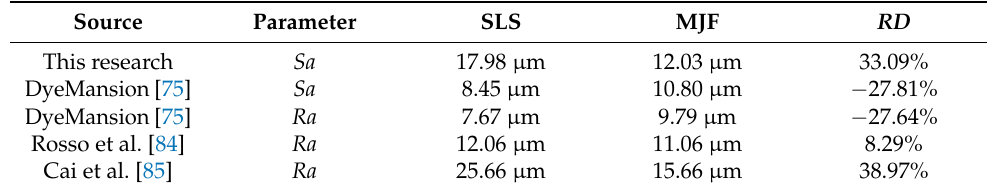
Table 4. Mean values of Ra and Sa parameters of samples made by SLS and MJF and the relative difference RD between them (comparing to SLS samples).